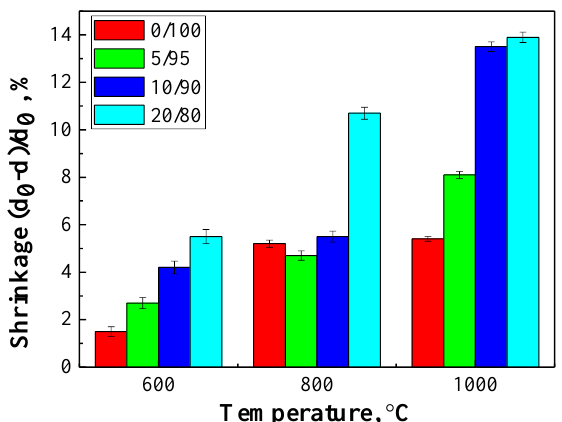
Figure 10. The shrinkage of the ceramic samples with a weight ratio of: Ca(PO 3 ) 2 /Ca 2 P 2 O 7 = 0/100; Ca(PO 3 ) 2 /Ca 2 P 2 O 7 = 5/95; Ca(PO 3 ) 2 /Ca 2 P 2 O 7 = 10/90; Ca(PO 3 ) 2 /Ca 2 P 2 O 7 = 20/80 in the range of 600 – 1000 °C temperatures.